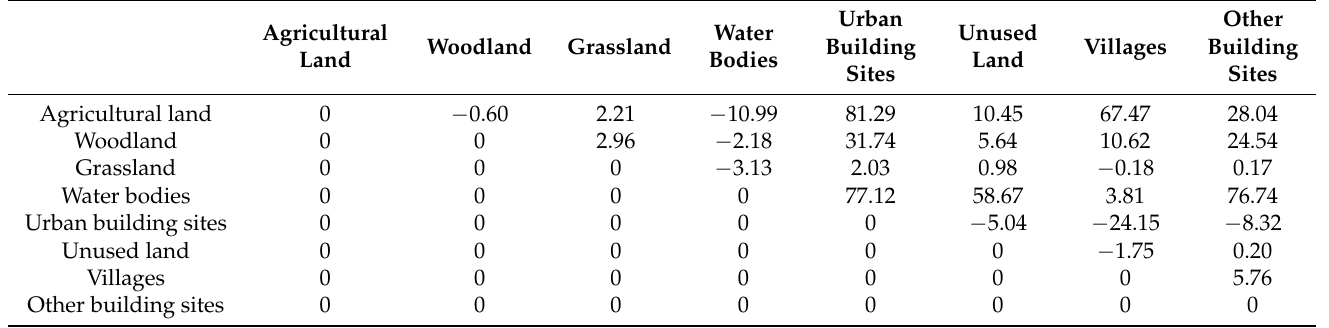
Table 5. Net land use transfer matrix between [0, 2.5] km buffer zone in Dalian. Agricultural Land